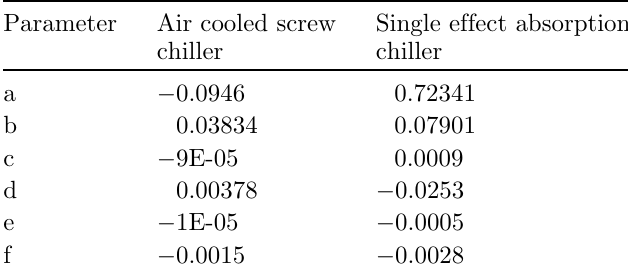
Table 3. Part load coef fi cient for air-cooled screw chillers [31].